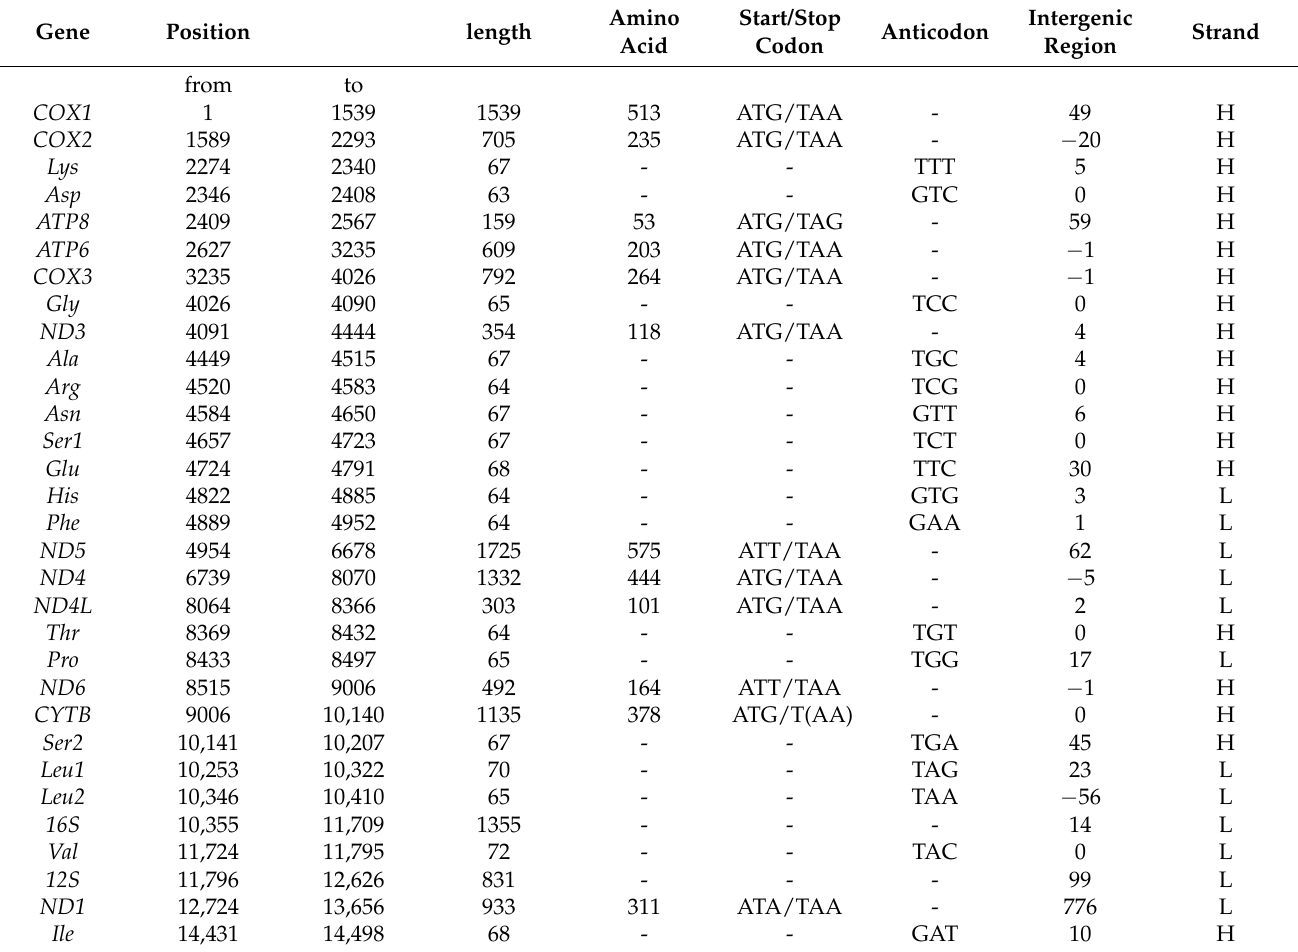
Table 1. Features of the mitochondrial genome of P. makianus